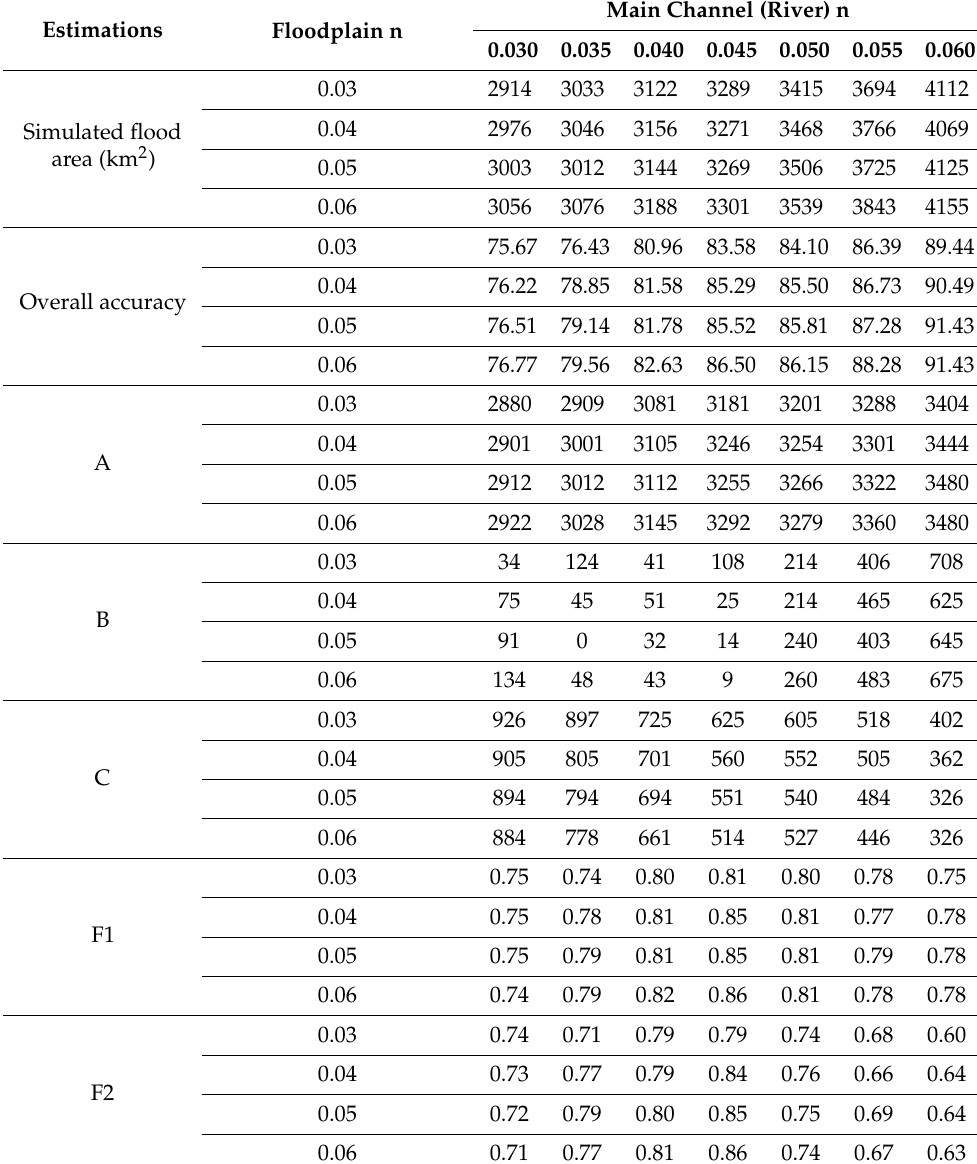
Table 3. Calibration assessment of the model using overall accuracy, F1, and F2 for the 1992 flood.